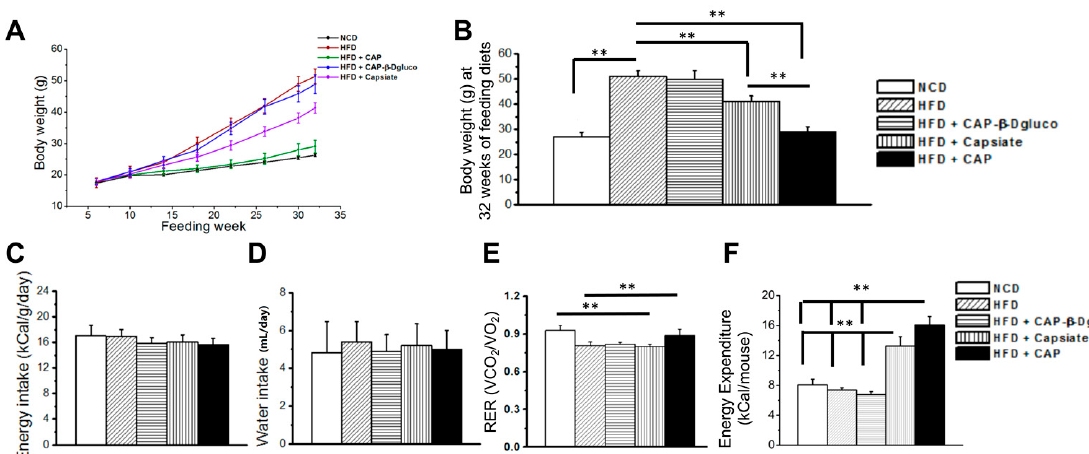
Figure 2. Effect of Capsaicin, Capsiate, and Cap- β - D Gluco on body weight gain, energy/water intake, and metabolic activity. A . Time course of body weight In NCD or HFD ( ± CAP, Capsiate or CAP- β - D Gluco) in wild type mice plotted against the feeding weeks. B . The mean body weight ± SEM for these groups of mice at the end of 32 weeks of feeding. C and D . The daily mean energy/water intake ± SEM for these mice. E and F . Mean respiratory quotient (respiratory exchange ratio) and heat (energy expenditure) ± SEM in these mice ( n = 8 to 12/condition). ** Statistical significance for p < 0.01.